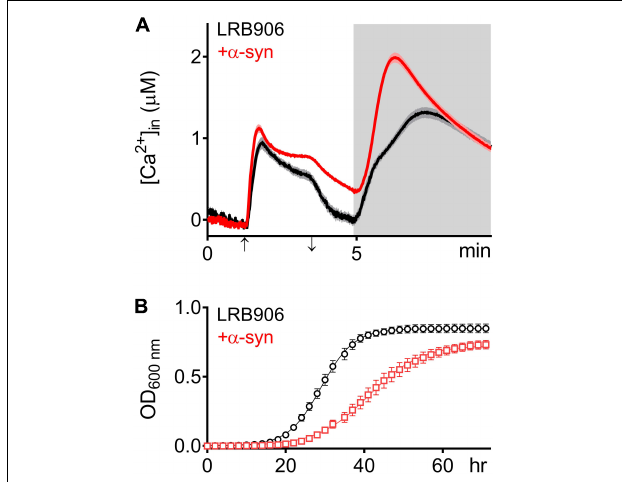
FIGURE 1 | α -Syn overexpression in LRB906 cells. (A) Averaged Ca 2 + transient ± SEM (thin lines either side of the Ca 2 + transient trajectory) of LRB906 (black trace) and LRB906 cells overexpressing α -syn (+ α -syn – red trace) at 37 ◦ C. Cells were initially perfused with Ca 2 + -free starvation medium and then transferred to a 10 mM external Ca 2 + medium for 2 min (indicated by up and down arrow on X -axis). Thereafter, cells were briefly exposed to Ca 2 + -free intracellular medium prior to membrane permeabilization using Triton X-100 (indicated by light gray zone). (B) Growth curves based on OD 600 density measurements at 25 ◦ C of LRB906 (black) and LRB906 cells overexpressing α -syn (+ α -syn – red curve). Each time point represents the average ± SEM of triplicate